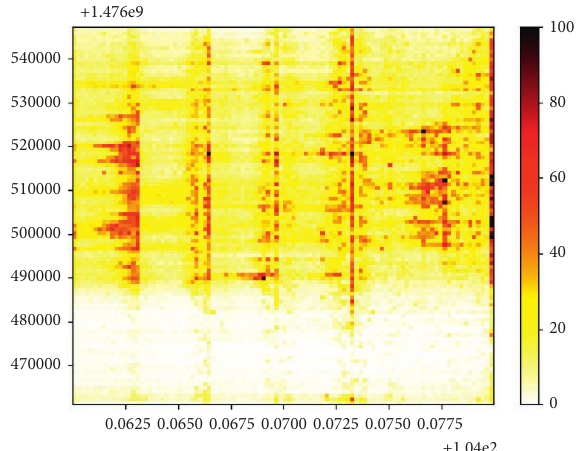
Figure 15: Daily variation of vehicle conflict risk in partially closed straight sections.